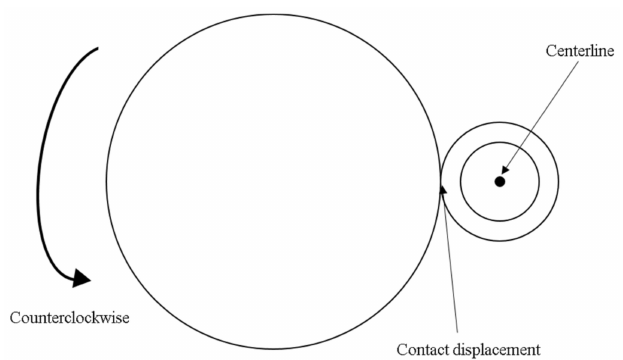
Figure 4. Schematic diagram of simulated rotational